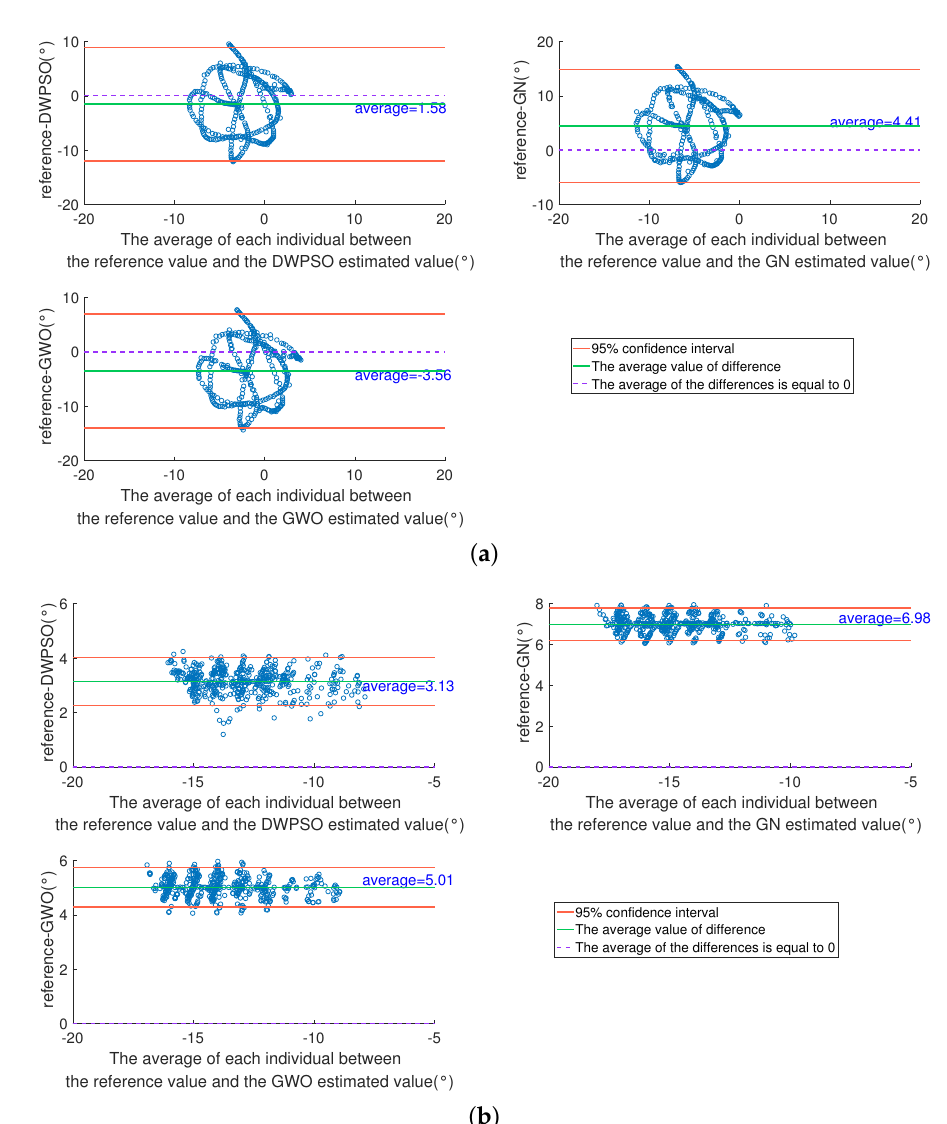
Figure 13. The Bland-Altman consistency analysis of estimated and reference values of three algo- rithms when IMUs in position 1. ( a ) H AA ; ( b ) K IE